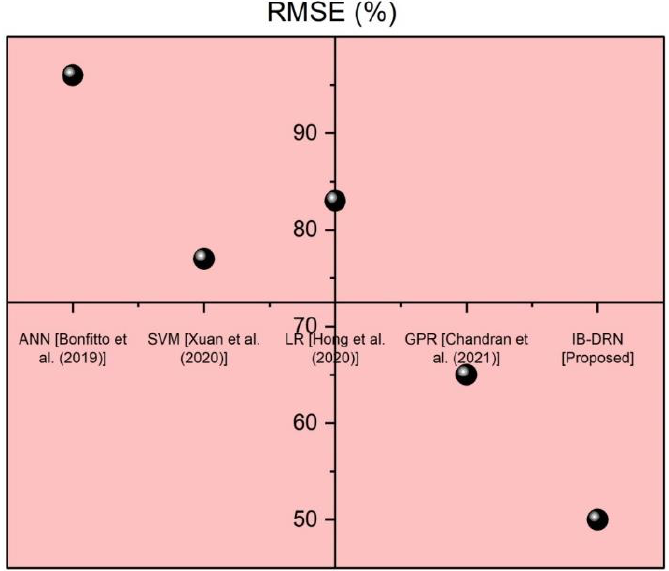
Figure 7. RMSE results of the proposed and existing referenced [1,28–30] methodologies [ANN [Bonfitto et al. (2019)], SVM[Xuan et al. (2020)], LR[Hong et al. (2020)], GPR [Chandran et al. (2021)]]. Figure 7 represents the precision results of the proposed and existing methodologies.